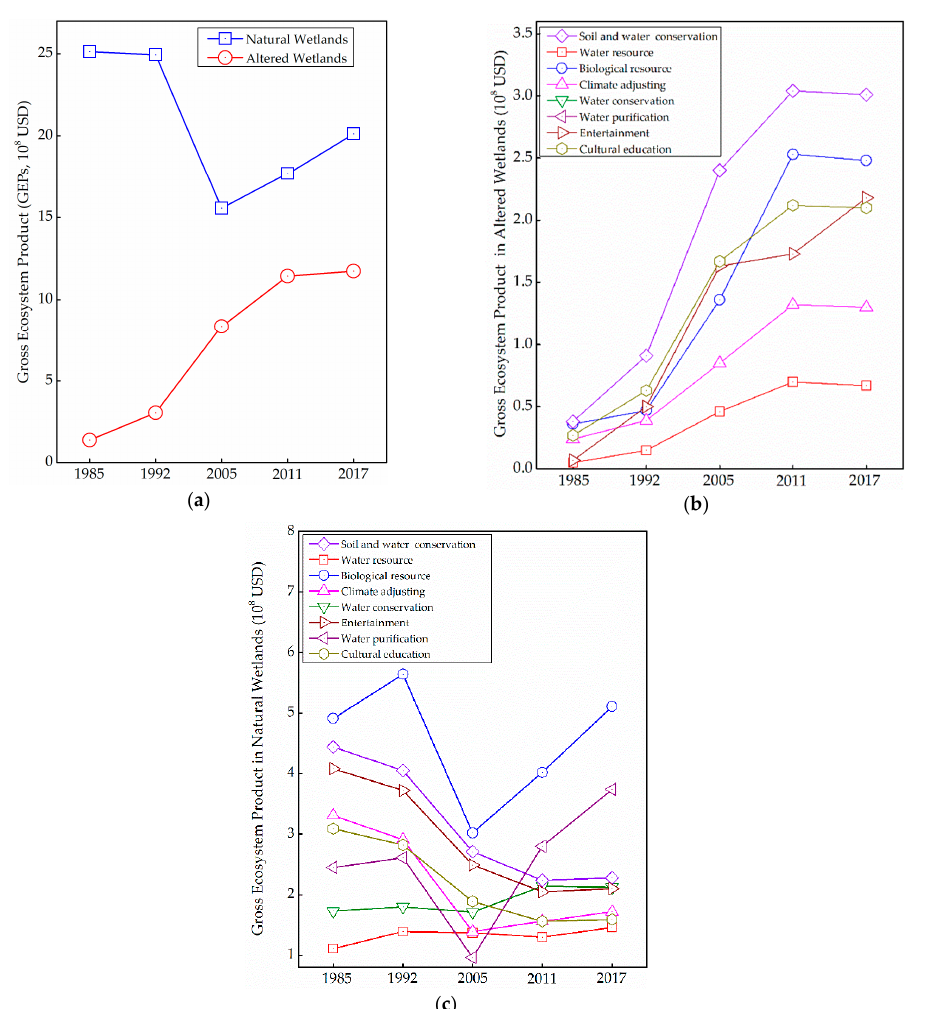
Figure 5. Comparison of gross ecosystem product in natural and altered wetlands. ( a ) Gross ecosystem product in natural and altered wetlands; ( b ) Gross ecosystem product in altered wetlands; ( c ) Gross ecosystem product in natural wetlands.